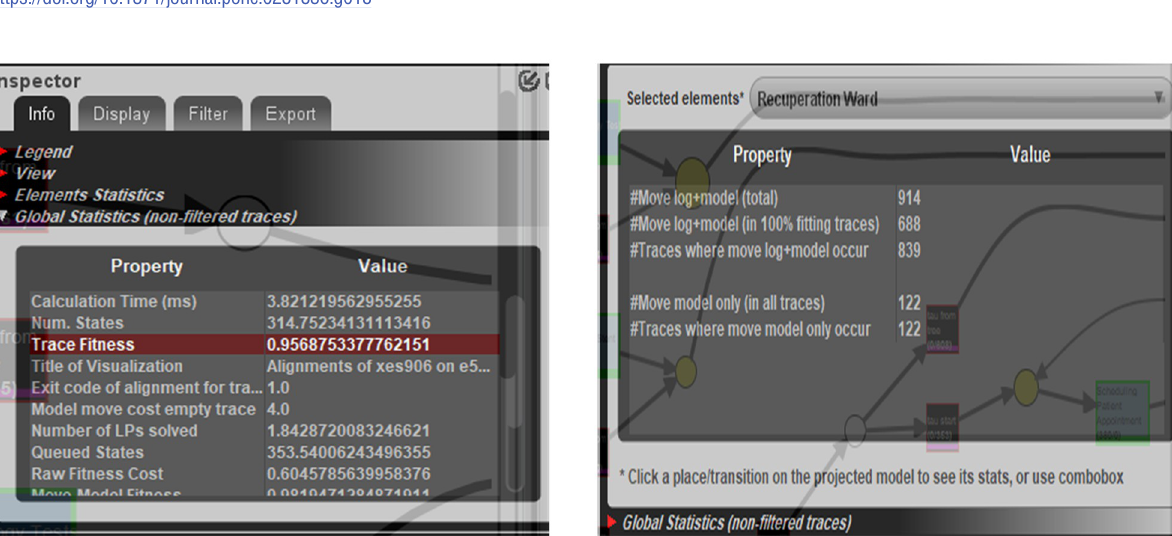
Fig 19. The resulting Statistical information obtained from replaying the event log with the Petri Net of the base model “Standard model” for conformance checking process.